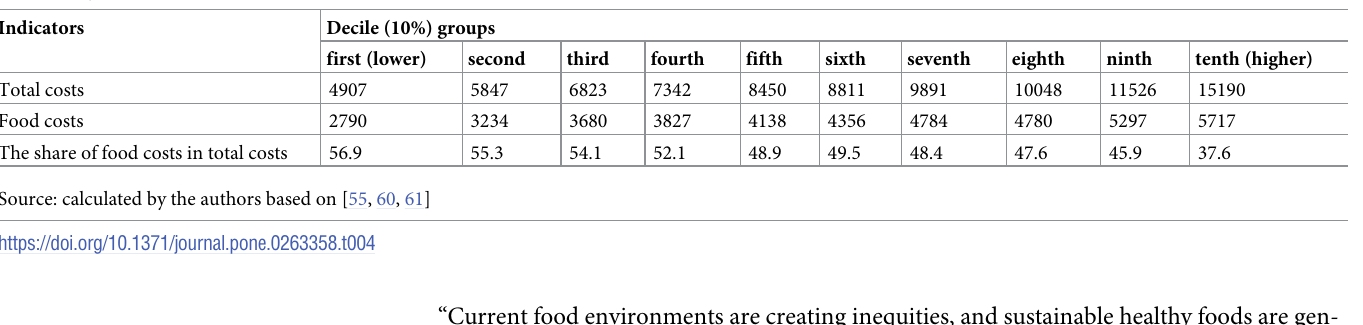
“Current food environments are creating inequities, and sustainable healthy foods are gen- erally more accessible for those of higher socioeconomic status” [83]. Some studies from Hun- gary also concluded that healthy food choice depends on the education level of people and also the financial situation [45, 84]. In 2020, the food cost differentiation indicator was 159.0%. This is evidence that in Ukraine there is a significant gap (almost 1.6 times) in the differentiation of the cost of food by social groups. This figure is calculated as the ratio between the cost of food for 20 percent of the high- est-income households and the cost of food for 20 percent of the lowest-income households. Despite the high share of food expenditures in the structure of household expenditures, the population of Ukraine consumes basic food products less than the approved norms. This is typical for all food groups except for potatoes, vegetables and cucurbits (melons, cucumbers, gourds etc.) which are consumed above the norm by 8.1 and 1.9 percent, respectively. The low- est coefficients of satisfaction of demand are for fish and fish products and milk and dairy products– 0.620 and 0.531, respectively. Thus, the provision of daily energy needs is due to the consumption of cheap but high-calorie foods. By 2013, inclusive, consumption of the basic food groups was gradually increasing. Deterio- ration in the volume and structure of consumption of the population of Ukraine began to occur starting from 2014. The year 2020 is characterised by a slight increase in the consump- tion of meat and meat products, milk and milk products, oil. Dynamics of consumption, ratio- nal norm of consumption (RNC) and satisfaction coefficient of needs (SCN) for separate products are given in Table 5. Table 5. Dynamics of food consumption by the population of Ukraine (per capita per year; kilograms). Main food-stuffs RNC